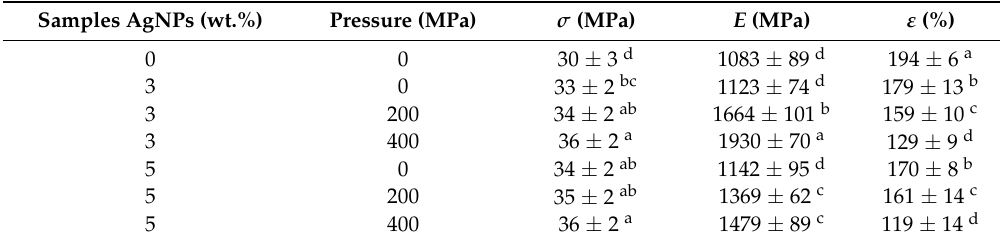
Table 3. Effects of high pressure treatment on the mechanical property of PLA/AgNPs nanocomposite films. Samples AgNPs